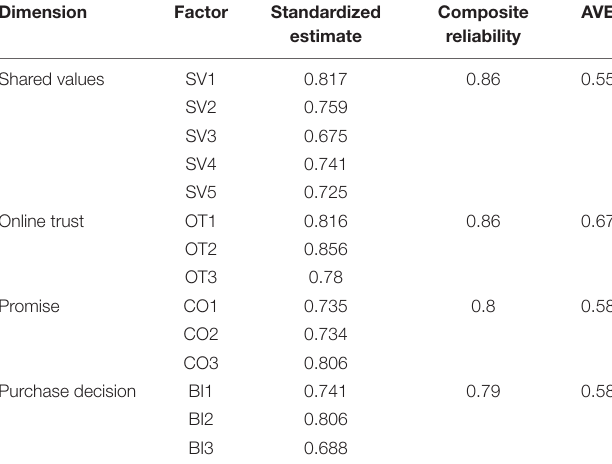
TABLE 3 | Confirmatory factor analysis.